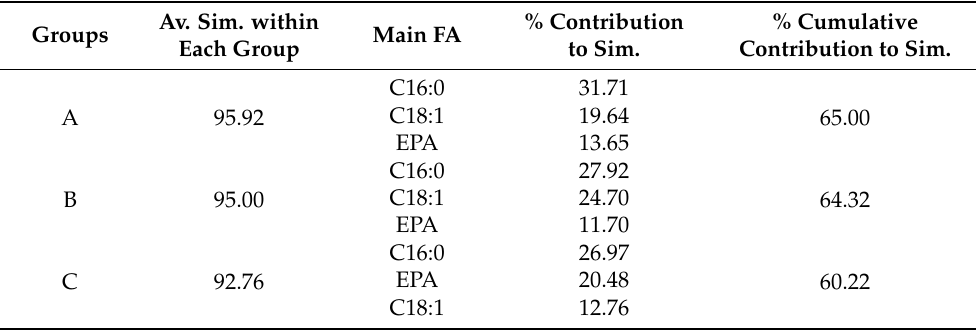
Table 6. SIMPER results regarding dissimilarities (diss.) between the groups identified (A— Lami- larities between different groups are provided by the average dissimilarity within each group (Av. diss. between groups)—the lower the dissimilarity (tending to 0), the higher the similarity within each group. The three FAs that contribute the most for the dissimilarity between groups are shown, as well as the percentage of that contribution and the cumulative contribution of those three FAs for the total dissimilarity between groups, in percentage. Replicates SL_R2 and SP_R3 were considered outliers of the analysis.